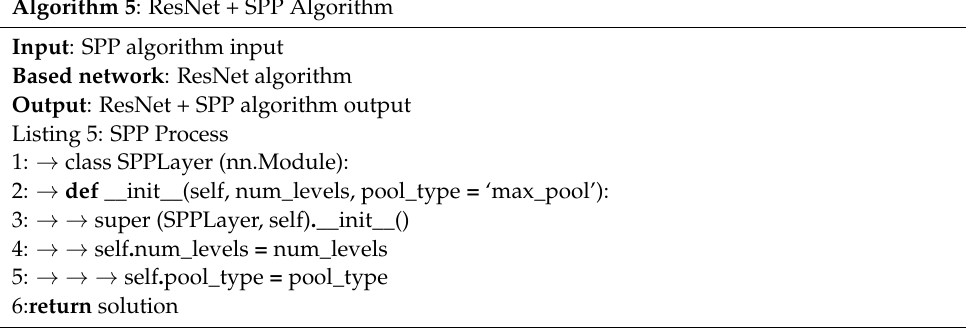
Algorithm 5 : ResNet + SPP Algorithm